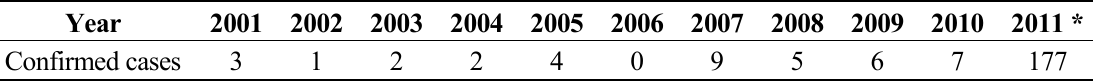
Table 1. Confirmed cases of leptospirosis in Nova Friburgo between 2001 and